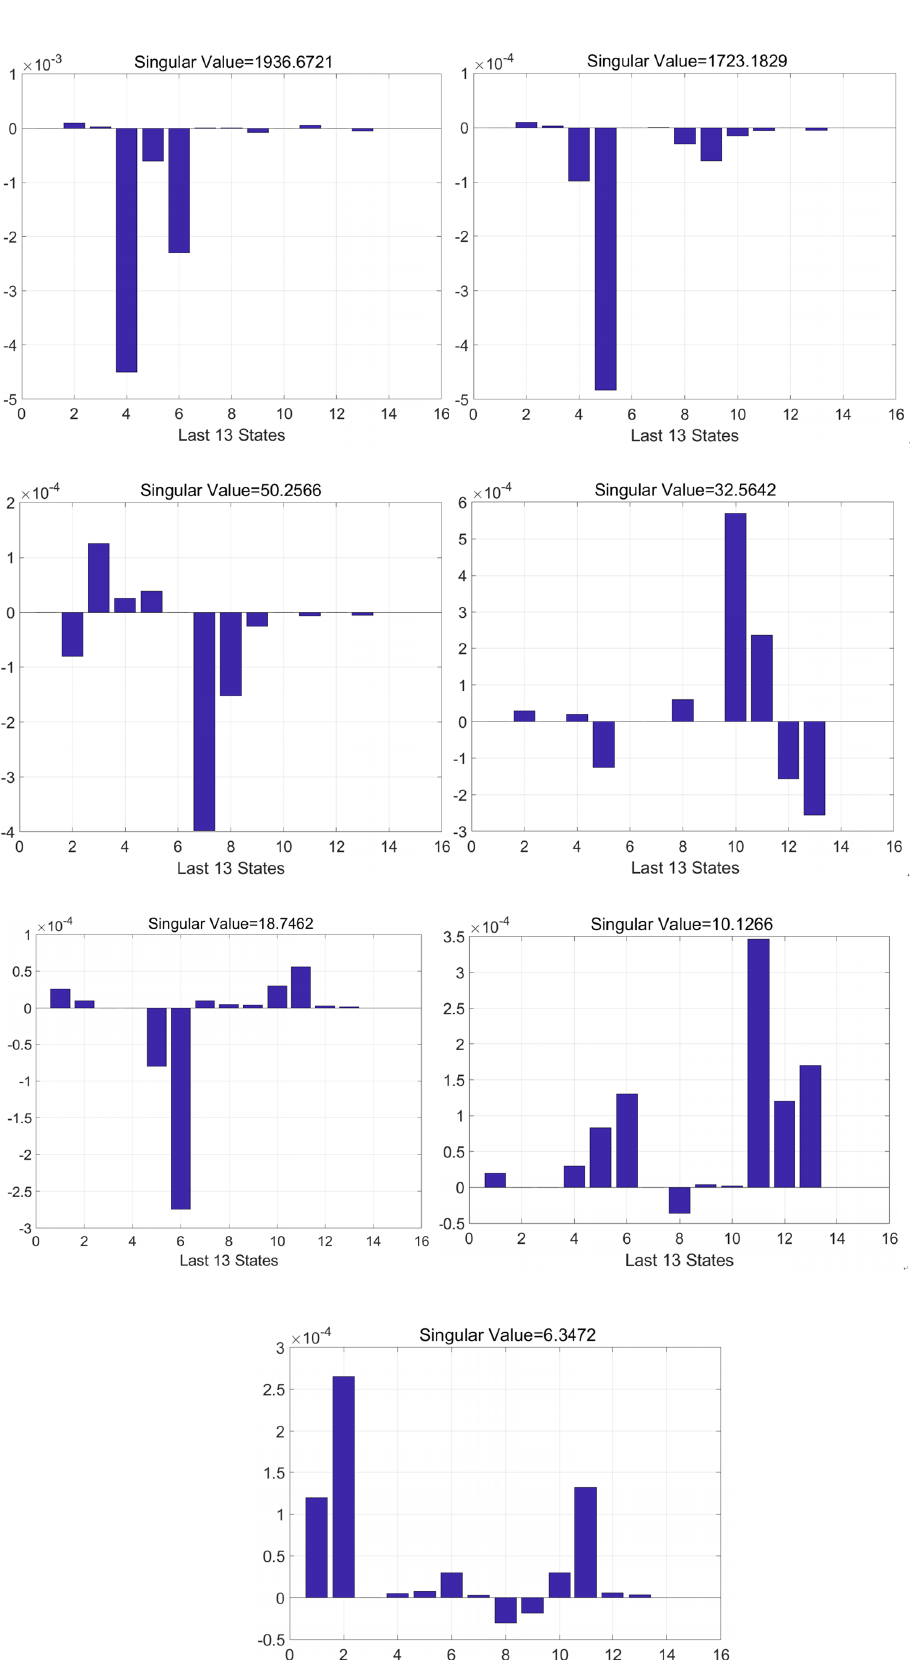
Figure 5. Observability